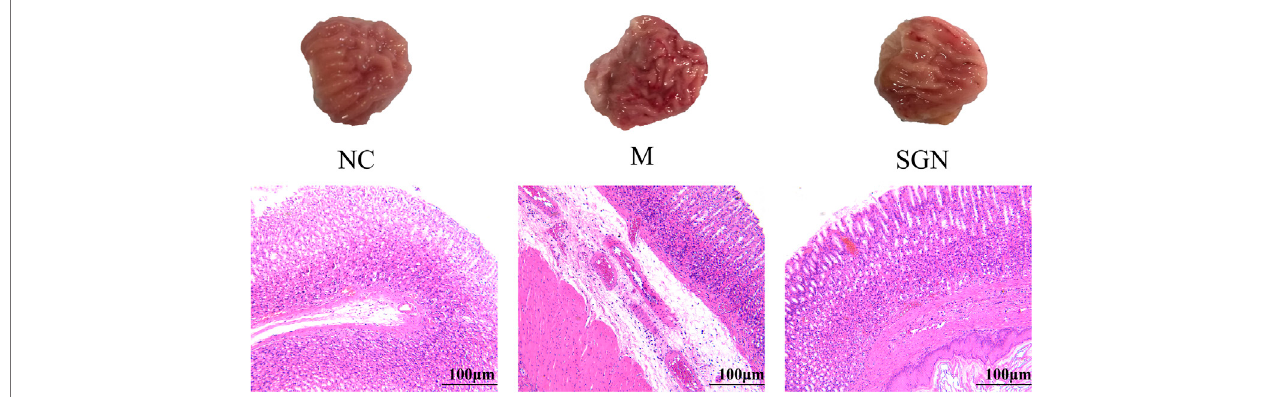
FIGURE 1 | Pathological section of rat stomach tissue in each group ( × 100). Black arrow: edema in the submucosal layer, eosinophil in fi ltration, damage to the glandular mucosal structure. Green arrow: bleeding on the mucosal surface, vasodilation, and congestion in the muscle layer.